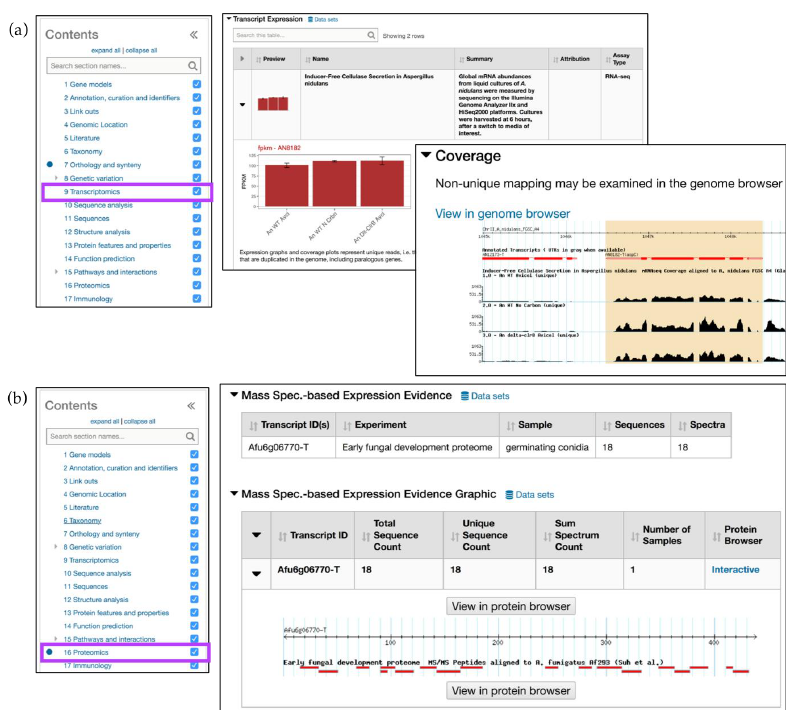
Figure 4. Simple searches and gene record pages, continued. ( a ) Transcriptomics menu (highlighted